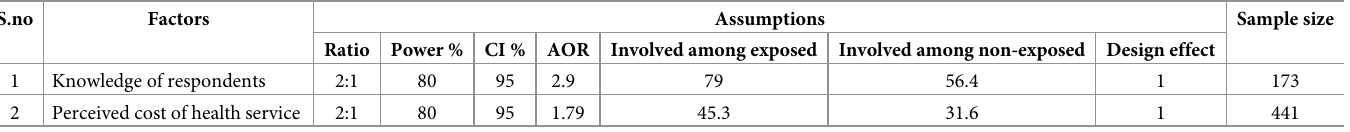
Table 1. Sample size calculation based on factors affecting male partners’ involvement in institutional